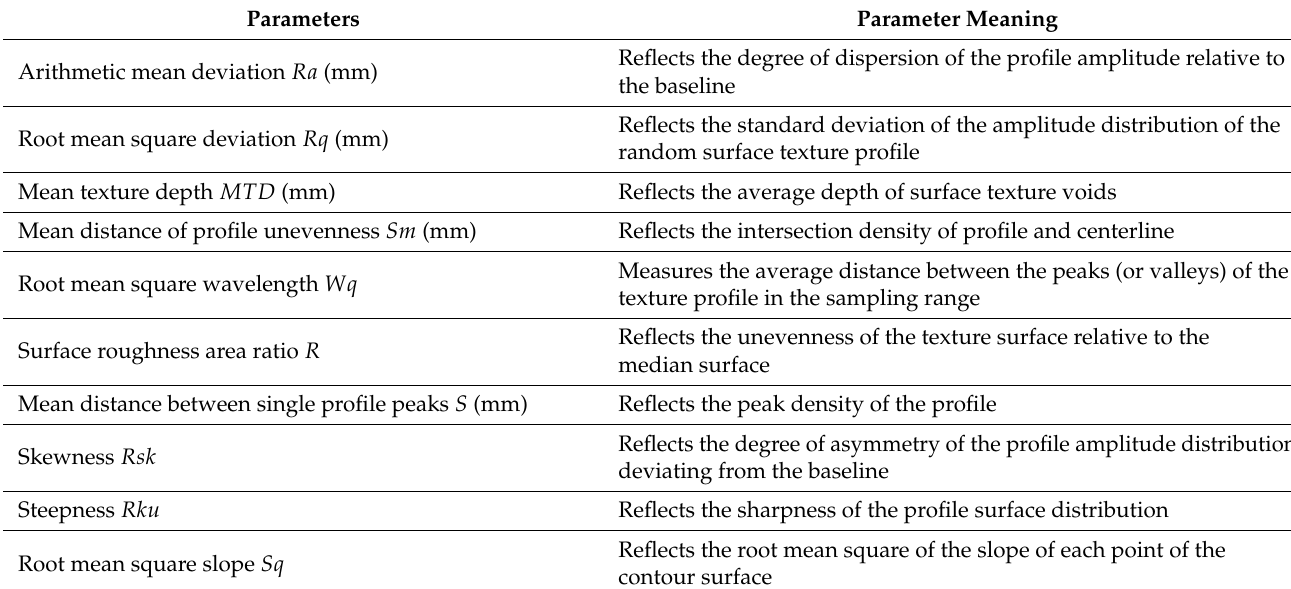
Table 2. Definition of 3D texture feature parameters.